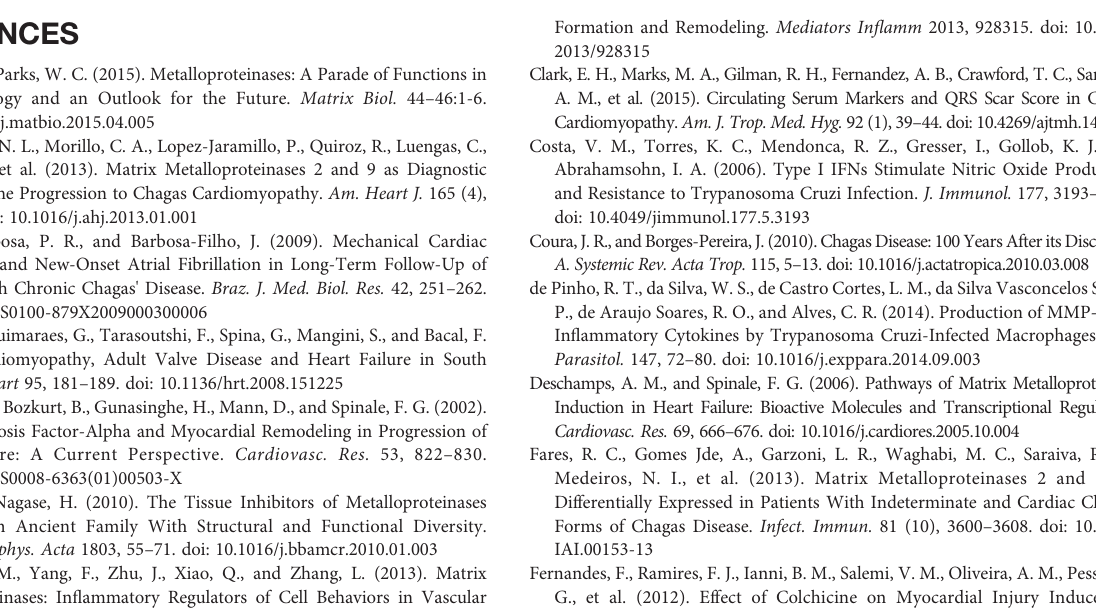
Supplementary Table 1 | Oligonucleotide primers used in gene expression analysis. Supplementary Table 2 | Histopathological features of the